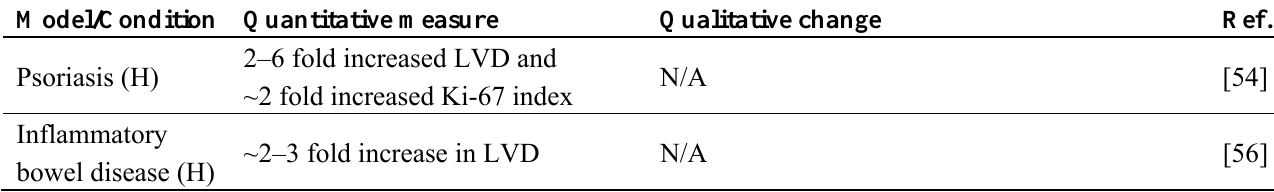
Table 1. Examples of inflammation induced quantitative and qualitative changes in